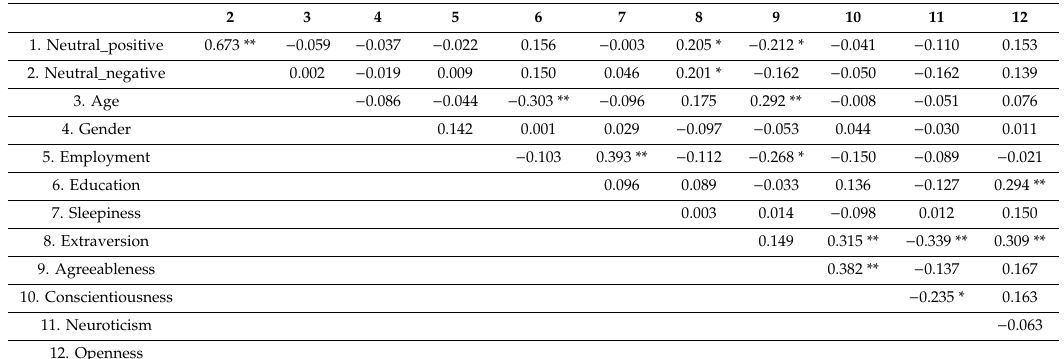
Table 2. Intercorrelation of variables under the